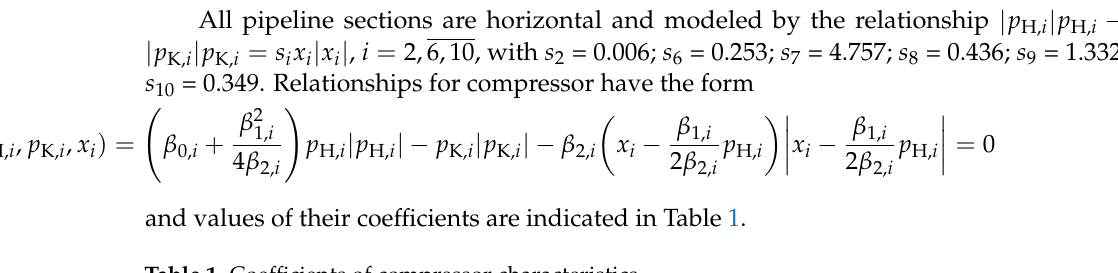
Table 1. Coefficients of compressor